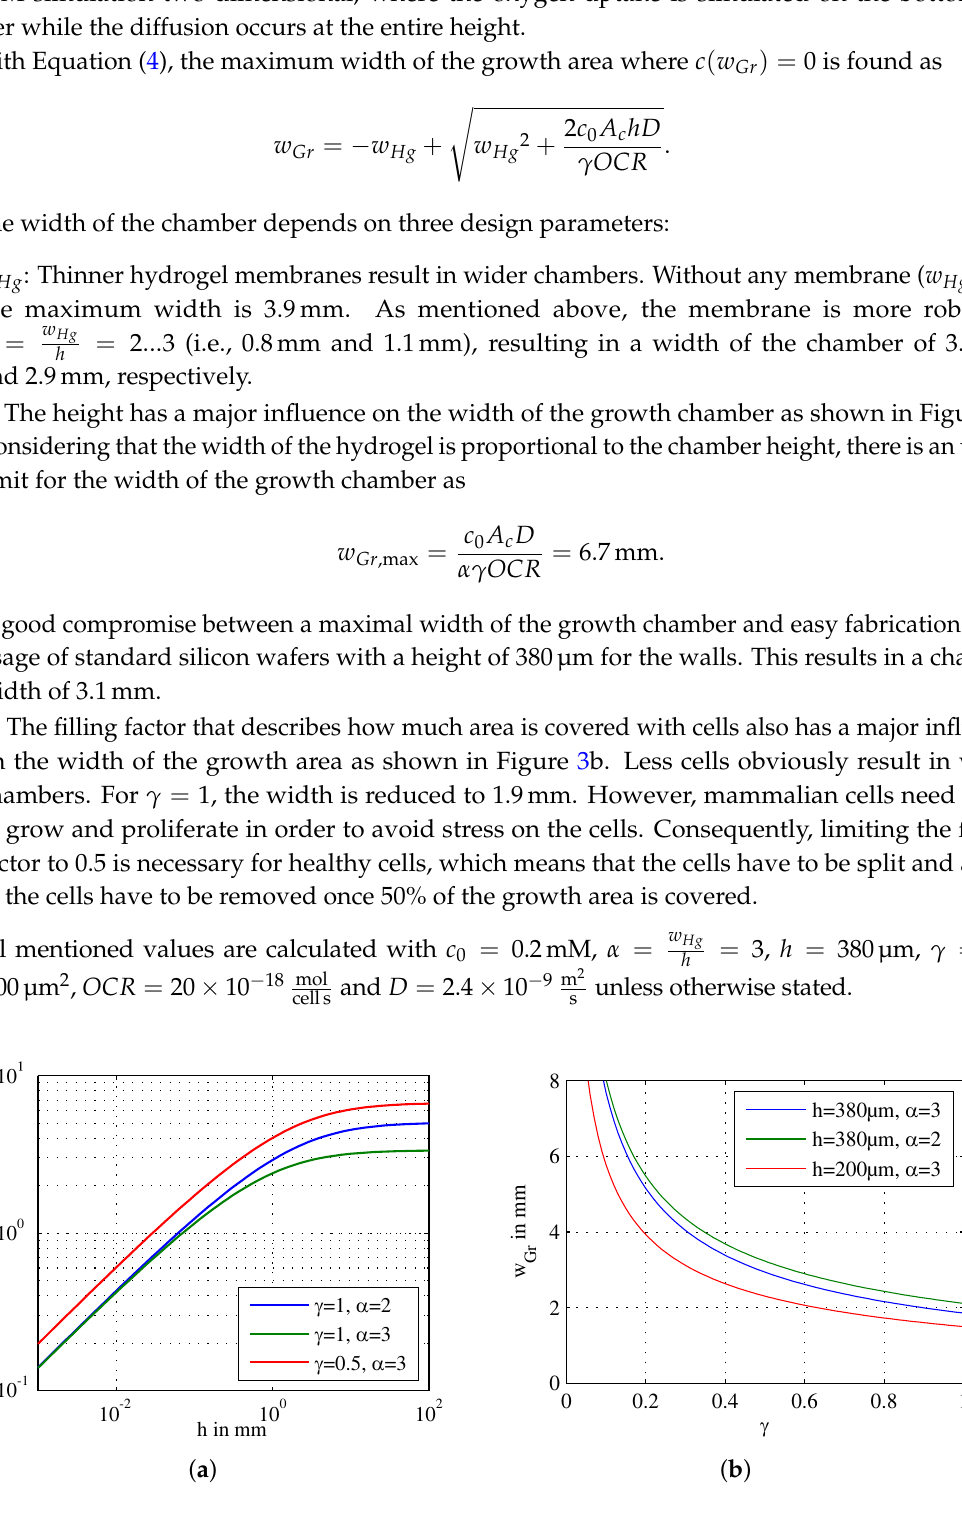
Figure 3. Maximal width of the growth chamber w Gr based on the analytical model: ( a ) width of the chamber as a function of the chamber height h for different filling factors γ and different α describing the ratio of the hydrogel width to the chamber height; ( b ) width of the chamber as a function of the filling factor γ , which describes the ratio of the surface that is covered with cells for different heights and α